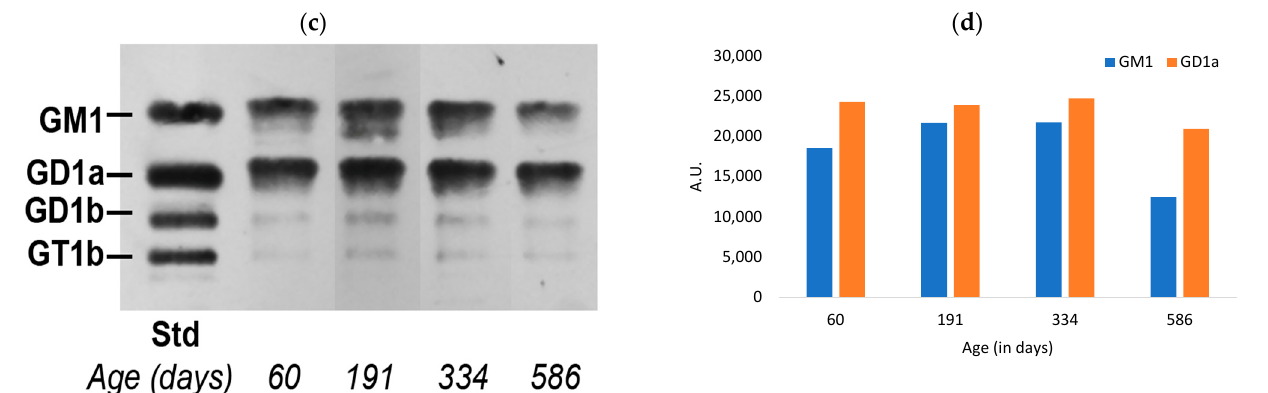
Figure 2. Quantification of a ‐ series gangliosides in the skin tissue of aging mice: ( a ) HPTLC of male mice skin gangliosides; ( b ) relative quantitation of the intensity of GM1 and GD1a; ( c ) HPTLC of female mice skin gangliosides; ( d ) relative quantitation of the intensity of GM1 and GD1a (A.U. = arbitrary units).